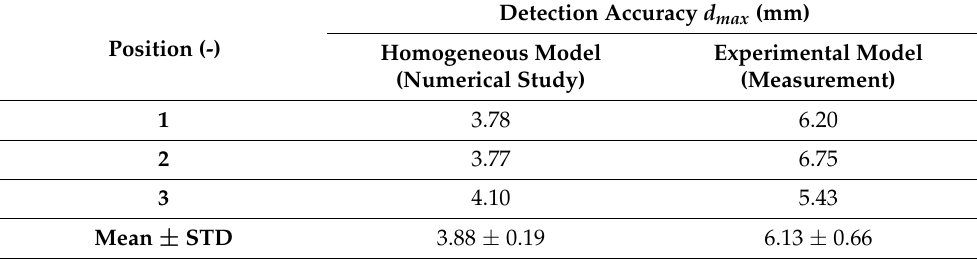
Table 7. Detection accuracy-Comparison of the accuracy achieved within the numerical model and